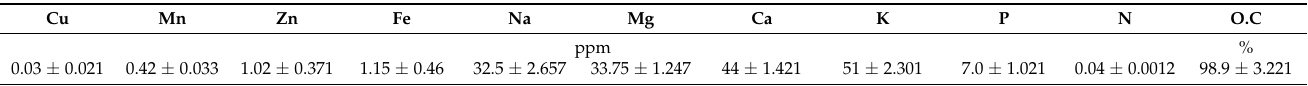
Table 1. Some chemical analyses of sugarcane bagasse aqueous extract (SBAE).